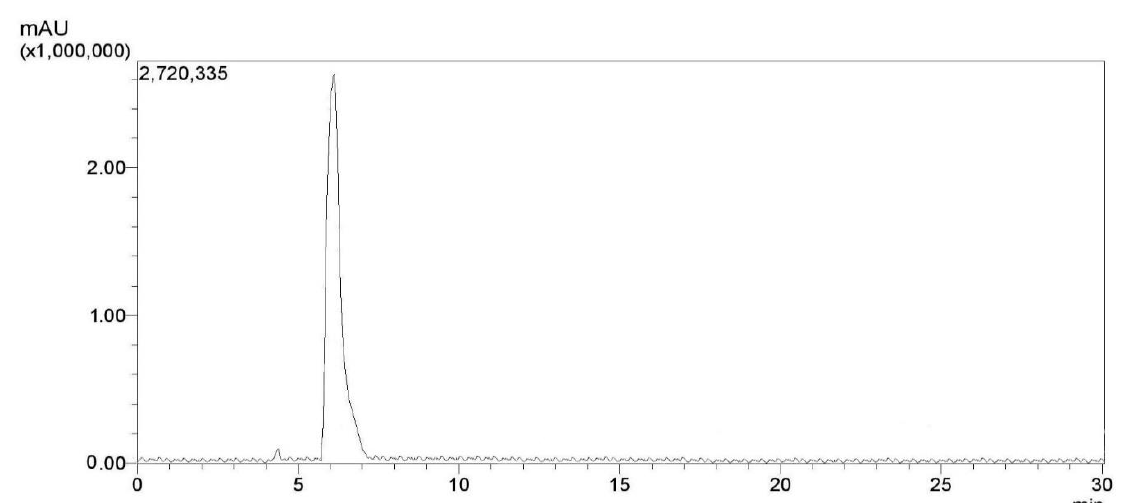
Figure 5. The HPLC analysis of purified N -acetylcysteine molecule.